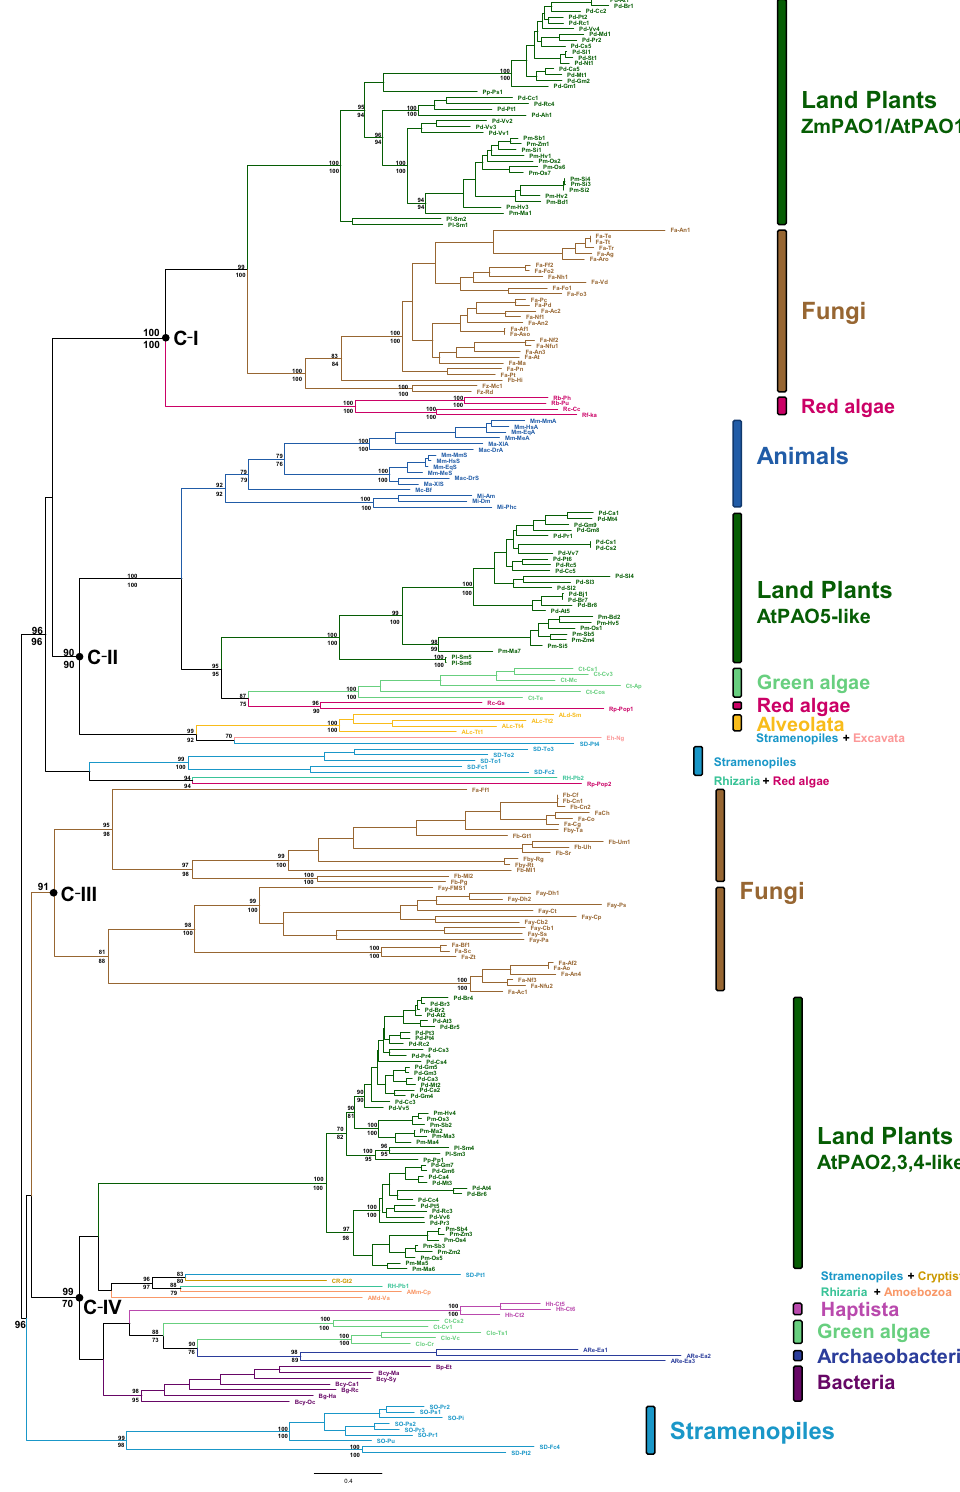
Figure 2. Phylogeny of eukaryote PAOs based on the 253 amino acidic sequences of the Eukaryota clade of Fig. 1. The tree shown was estimated with the Maximum likelihood method under the WAG + I + G model of amino acid replacement. Nodal support (> 70) is reported along the main branches: above, ultrafast bootstrap approximation (1000 replicates); below, SH-like approximate likelihood ratio test (1000 replicates). Main clades and eukaryote groups are